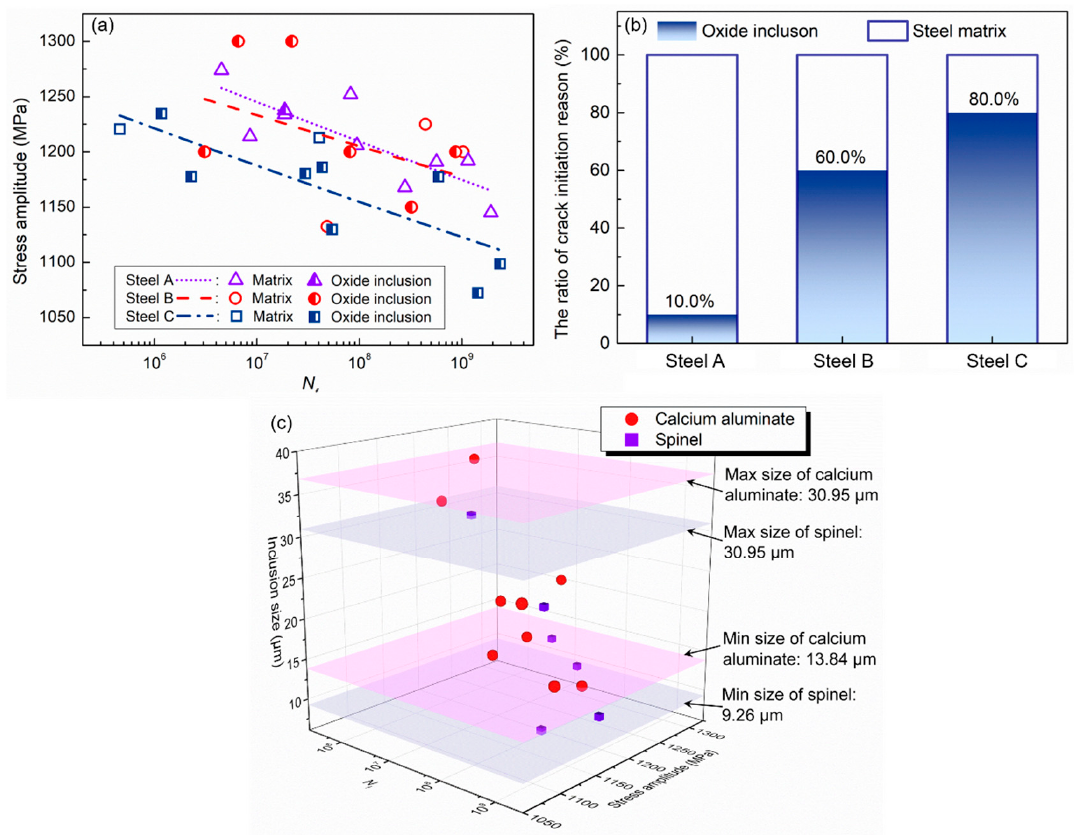
Figure 5. Fatigue properties of steel from steels A, B, and C: ( a ) S-N curves; ( b ) the ratio of fatigue initiation reasons; ( c ) the oxide inclusion induced fatigue characters (fatigue life vs. stress amplitude vs.